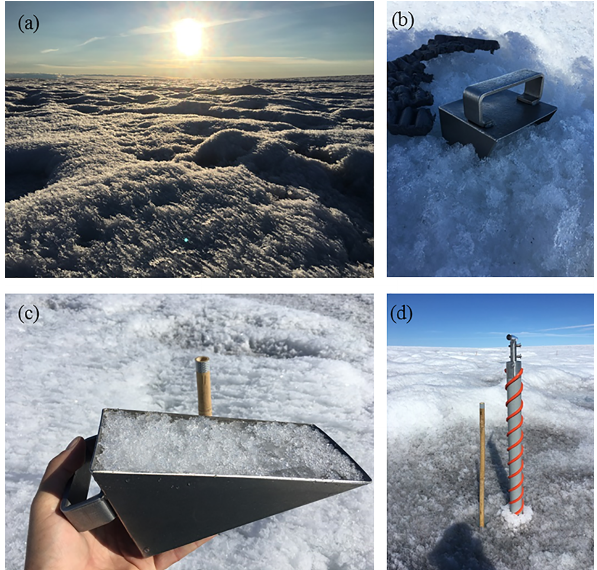
Figure 3. (a) A surface weathering crust was pervasive through- out the study area, characterized by small scale topographic vari- ability and cryoconite holes. (b–c) A 1000cm 3 steel snow density sampler was vertically inserted into the upper 20cm weathered